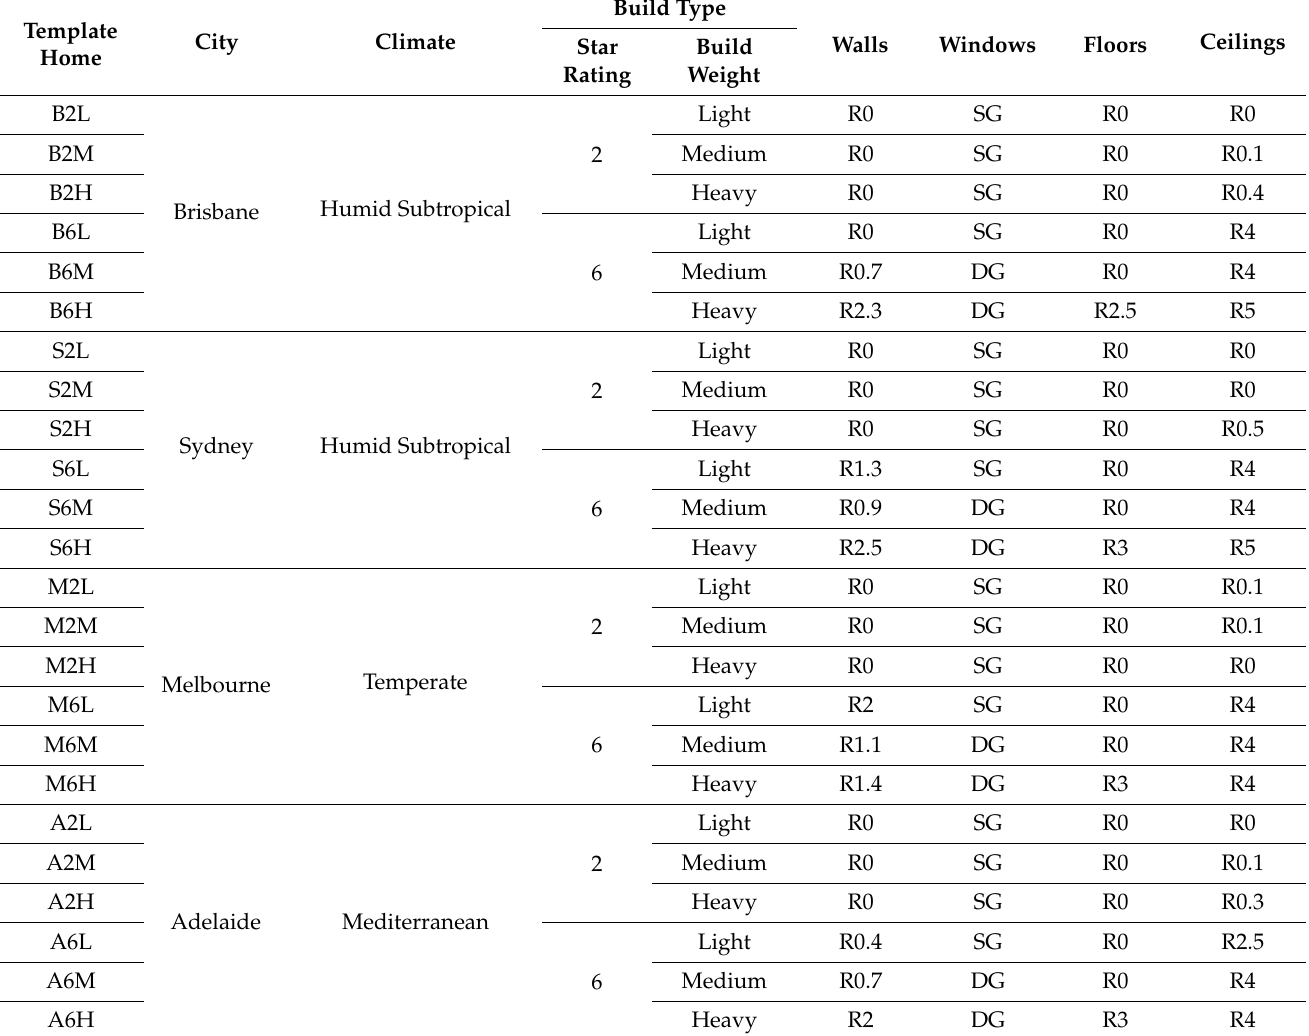
Table 1. Build characteristics for the twenty-four template homes created in AccuRate. Rx = the R-value of the construction material (K.m 2 /W), SG = Single glazing and DG = Double